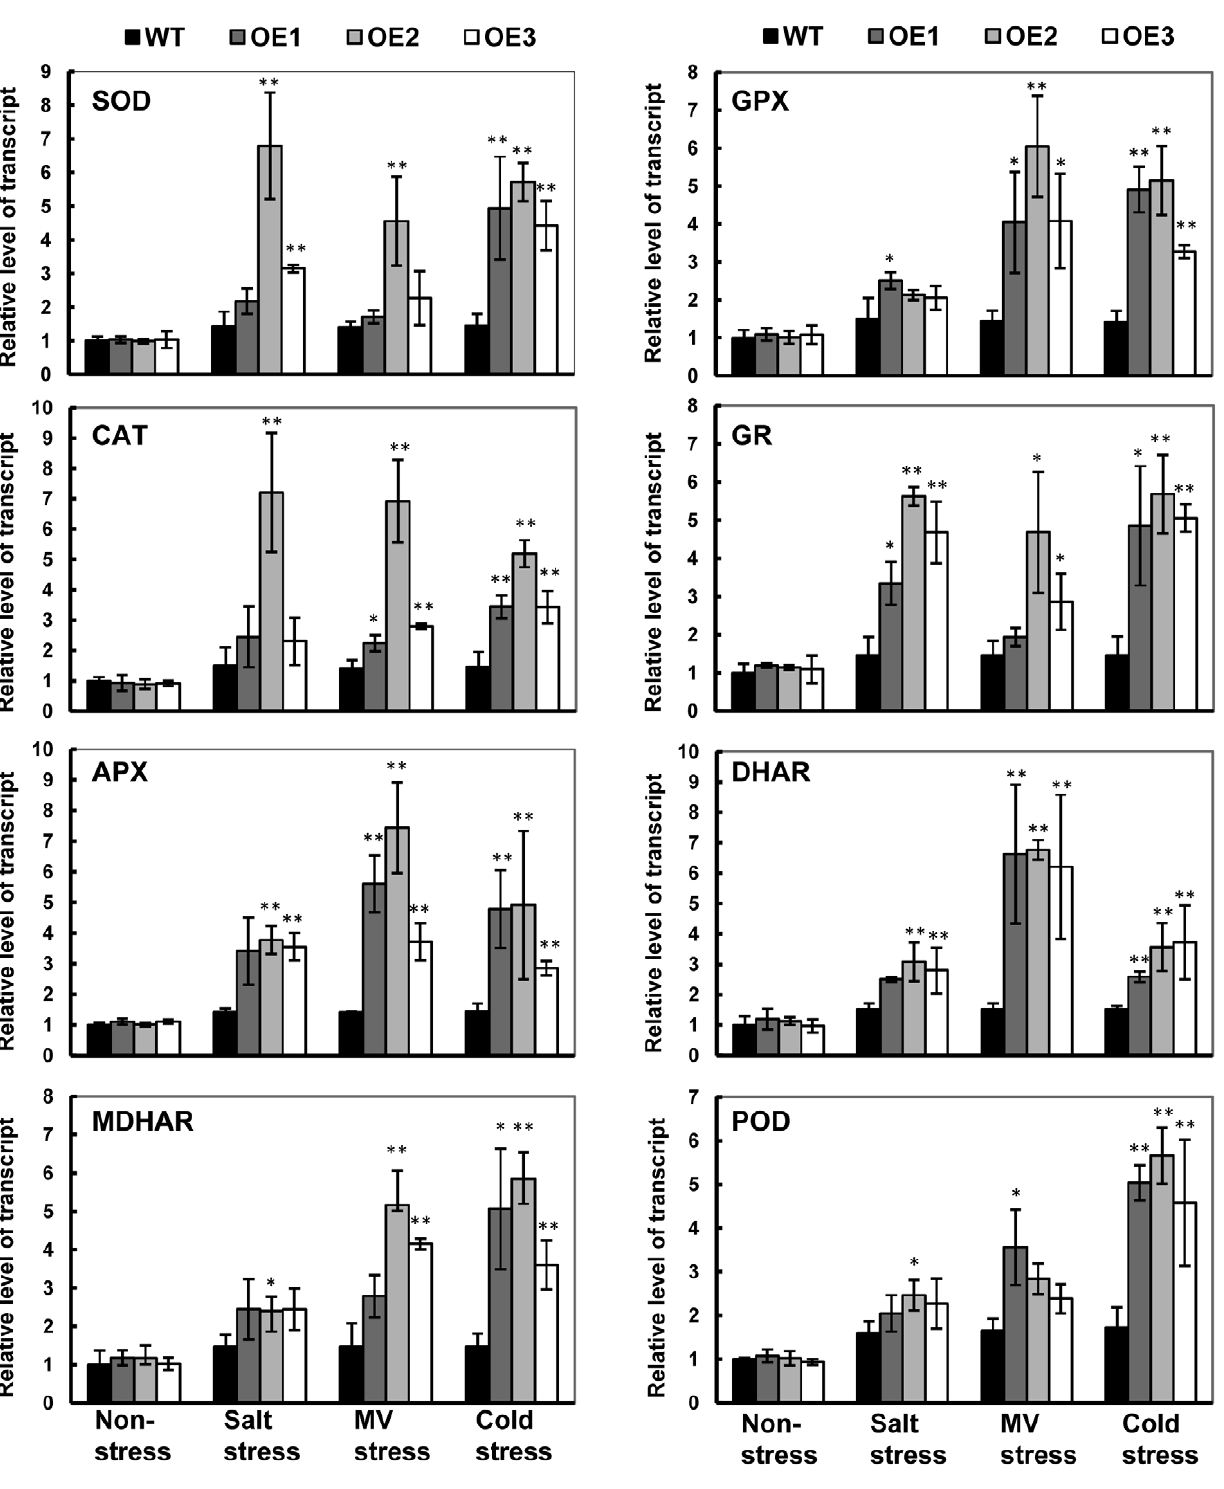
Figure 7. Relative level of transcript of ROS-scavenging genes in wild-type (WT) and SoBADH transgenic (OE) plants under stresses. The transcript level of each gene in the leaves under non-stressed condition was used as a reference for comparison. APX, ascorbate peroxidase; BADH, betaine aldehyde dehydrogenase; CAT, catalase; DHAR, dehydroascorbate reductase; GPX, glutathione peroxidase; GR, glutathione reductase; MDHAR, monodehydroascorbate reductase; POD, peroxidase; PSII, photosystem II; ROS, reactive oxygen species; SOD, superoxide dismutase. Values represent the mean 6 SD (n=9). Asterisks indicate a significant difference from that of WT at * P , 0.05 or ** P , 0.01 by t -test.